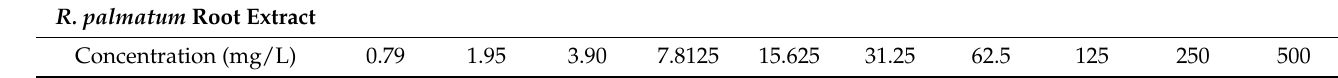
Table 1. Final concentrations of R. palmatum root